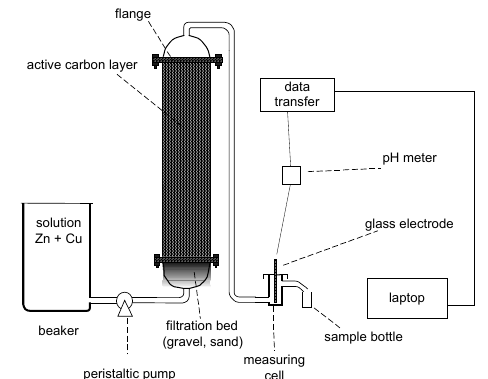
Figure 1. Scheme of the column experiment.